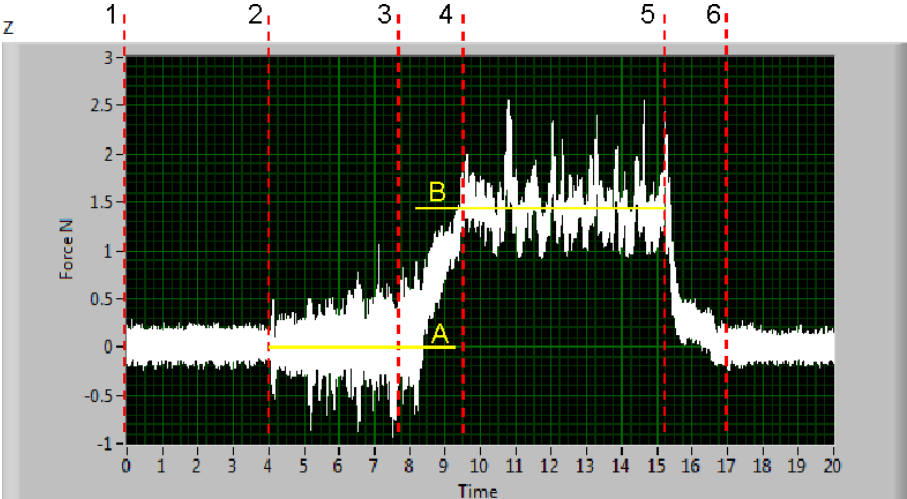
Figure 7. Force signal in z -axis after processing in LabVIEW program. Description of force signal